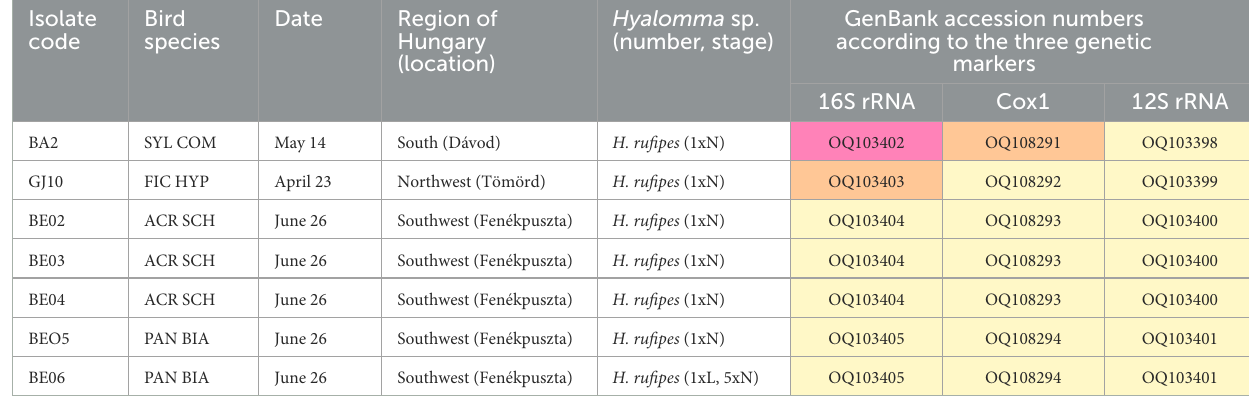
TABLE 2 Data of Hyalomma ticks collected in 2022 from birds at various ringing stations in